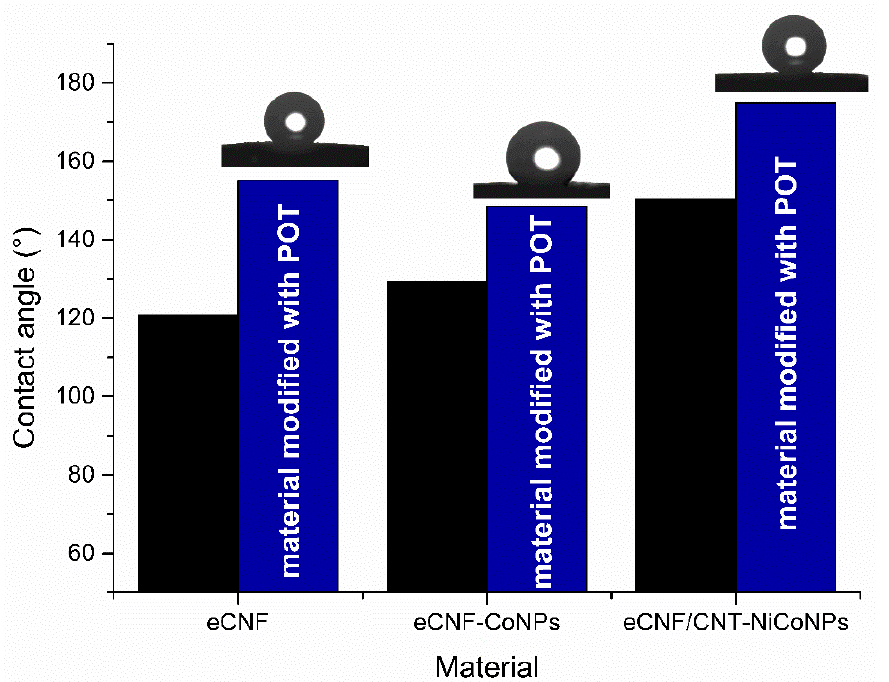
Figure 2. Contact angle values for POT-modified carbon materials (blue) compared to those previ- ously published in [14] ously published in [14] (black).